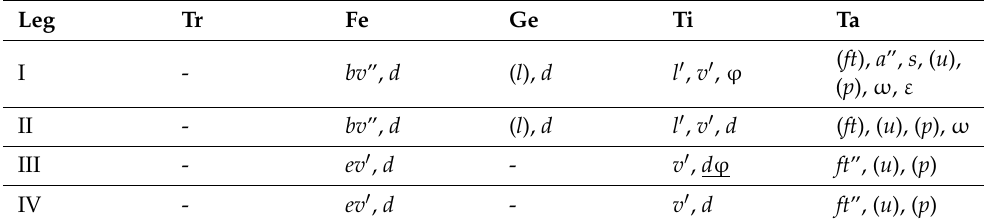
Table 2. Leg setae and solenidia of adult female Paralycus persephone sp.